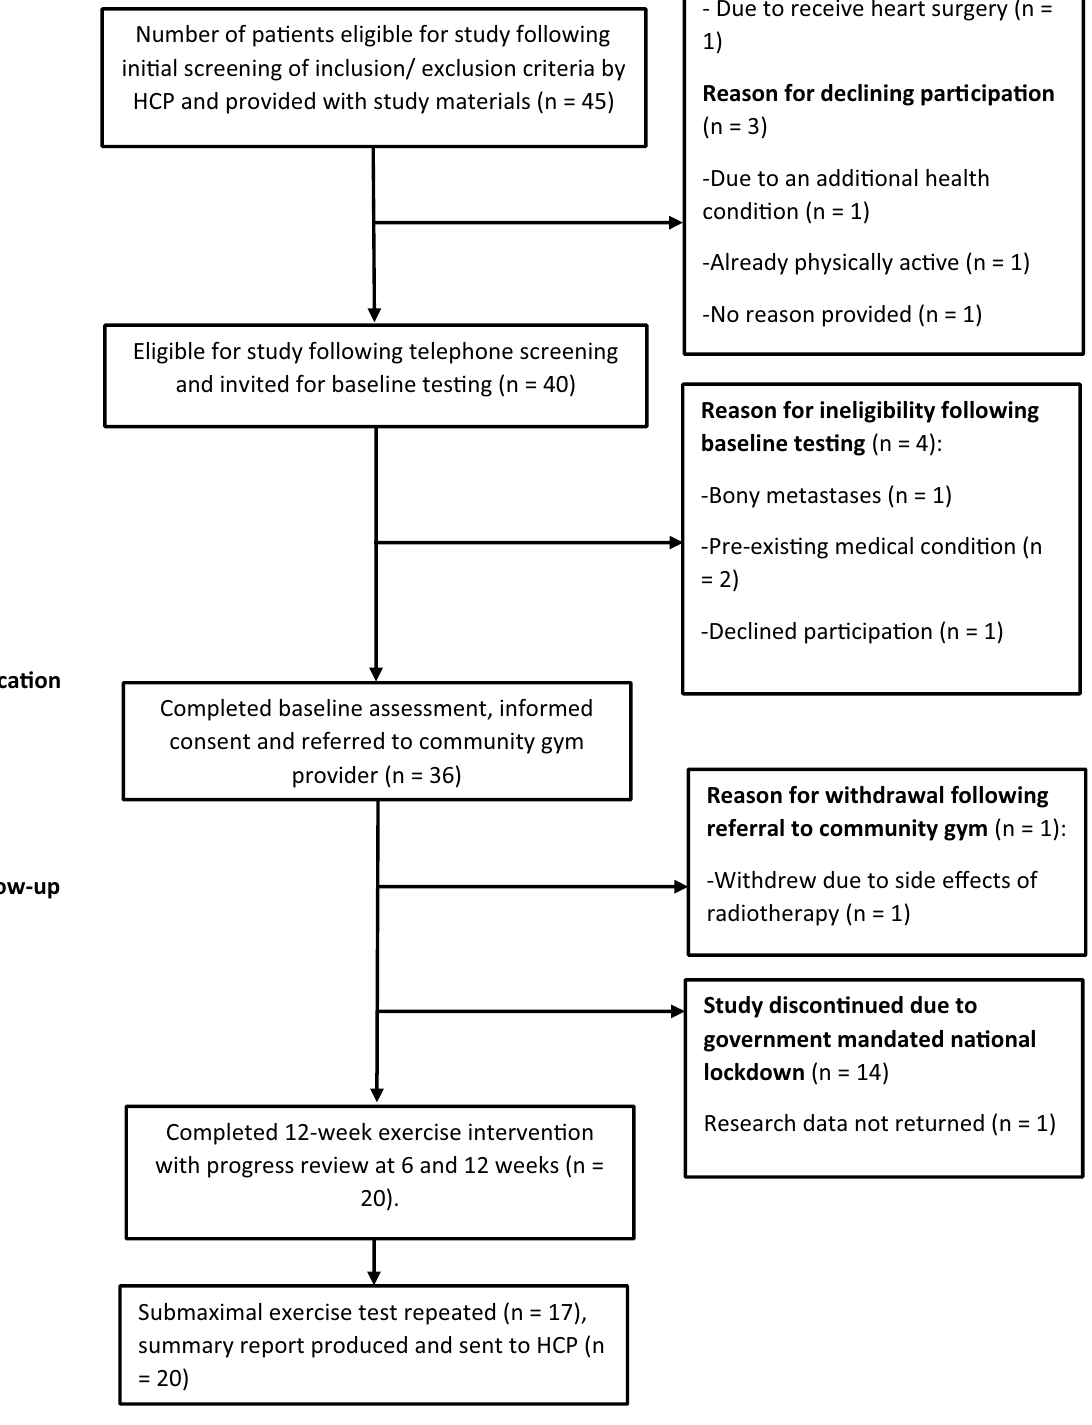
Figure 2. STAMINA trial CONSORT diagram: Patient recruitment and